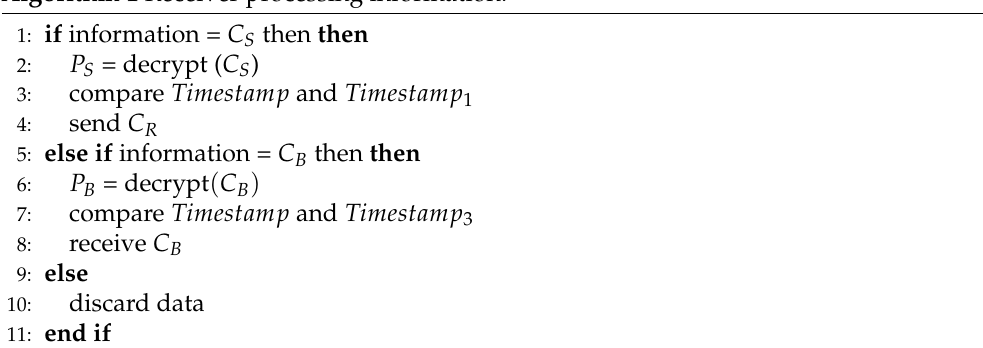
Algorithm 1 Receiver processing information.